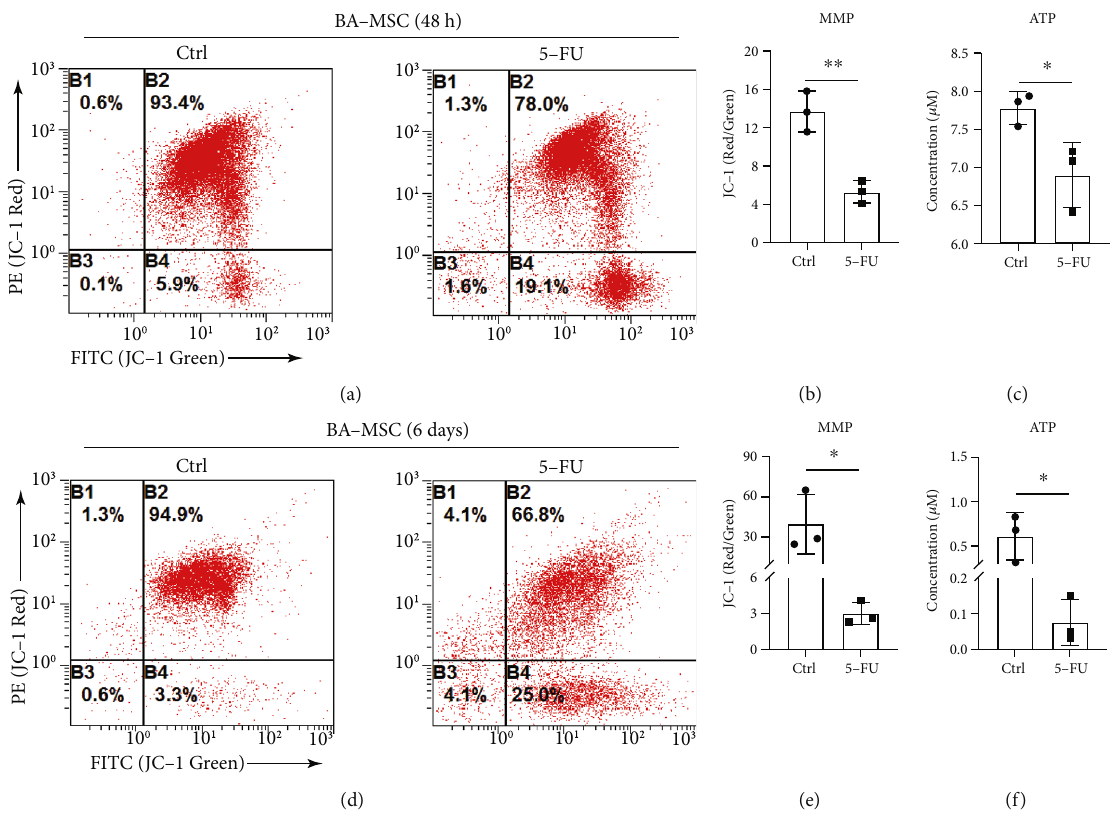
Figure 4: Analysis of mitochondrial function in BA-MSCs after 5-FU chemotherapy. (a) Flow cytometric plots of MMP detection in DMSO-treated BA-MSCs and 5-FU-treated BA-MSCs. (b) Flow cytometry analysis of MMP in DMSO-treated BA-MSCs and 5-FU- treated BA-MSCs ( n = 3 ). (c) ATP analysis of DMSO-treated BA-MSCs and 5-FU-treated BA-MSCs ( n = 3 ). (d) Flow cytometric plots of MMP detection of BA-MSCs in control mice and 5-FU-induced myelosuppression mice. (e) Flow cytometry analysis of MMP of BA- MSCs in control mice and 5-FU-induced myelosuppression mice ( n = 3 ). (f) ATP analysis of BA-MSCs in control mice and 5-FU- induced myelosuppression mice ( n = 3 ). All data are presented as mean ± SEM . Statistics: unpaired Student ’ s t -test (ns: not signi fi cant; ∗ p < 0 : 05 and ∗∗ p < 0 : 01